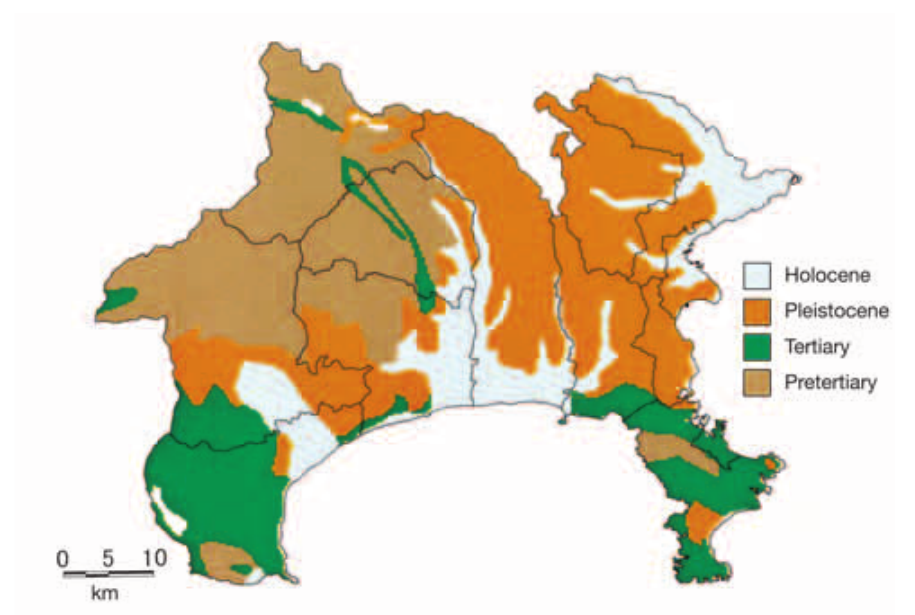
Fig. 6. Geological map of Kanagawa Prefecture.